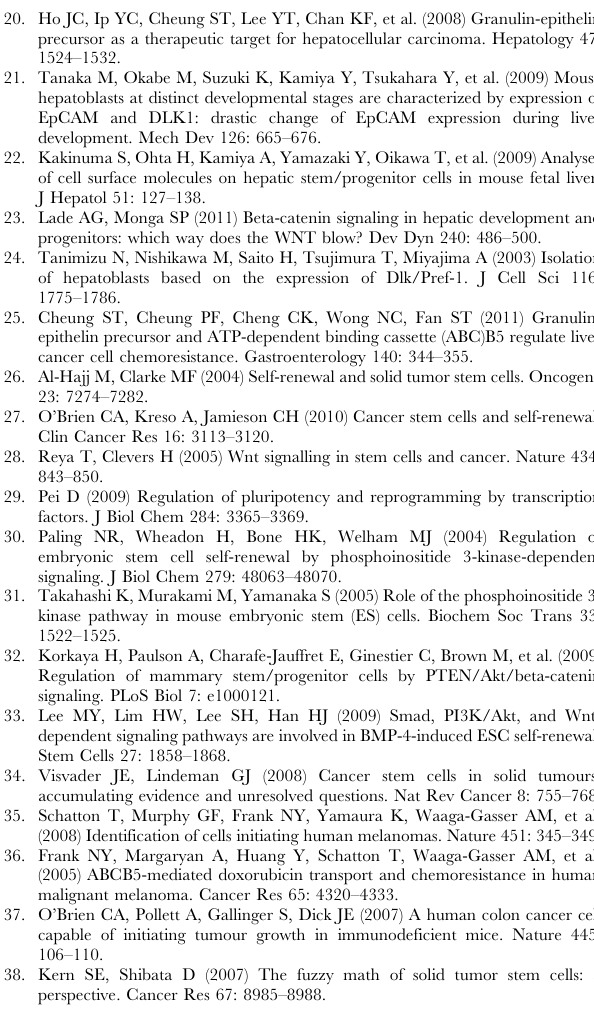
ABCB5 was measured by intracellular staining, while that of CD133 and EpCAM was assessed by surface staining. Cells co- expressing the respective markers were shown in the upper right quadrant of each scatter plot. Data are expressed as mean percentage of cells 6 SD. (TIF) Figure S5 In vitro self-renewal ability of GEP positive and ABCB5 positive cells. Flow cytometric analyzes showing the increasing GEP and ABCB5 expression in primary culture established from GEP high ABCB5 + cells-induced xenograft tumors over a 3-week culture period.